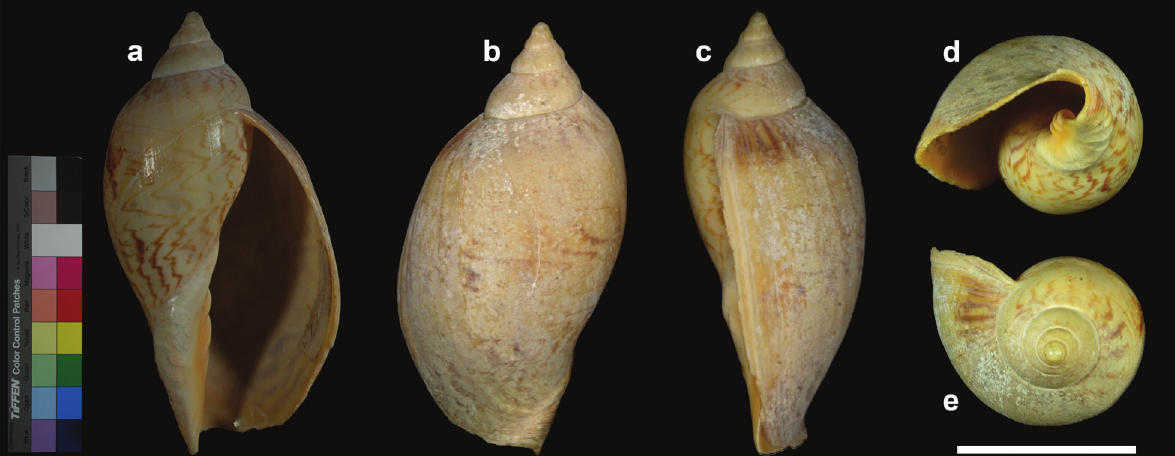
Figure 5. Voluta ambigua subnodosa , holotype figured by Lahille (1895: pl. XI, fig. 9) a Apertural view b Dorsal view c Lateral view d Umbilical view e Apical view. Scale bar: 5 cm.